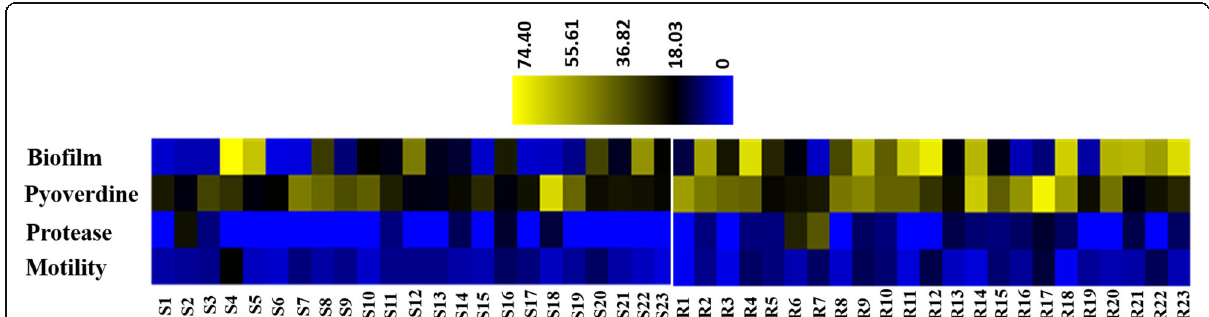
Fig. 6 Heat map representing virulence factors of ocular clinical isolates of P. aeruginosa . The Virulence factors for 46 clinical isolates were tested by different methods specified earlier. Heat map was constructed to compare the S-PA and MDR-PA isolates. S1-S23 denotes drug susceptible strains, R1-R23 denotes MDR-PA strains. Blue represents a lower level of expression and yellow represents a higher level of